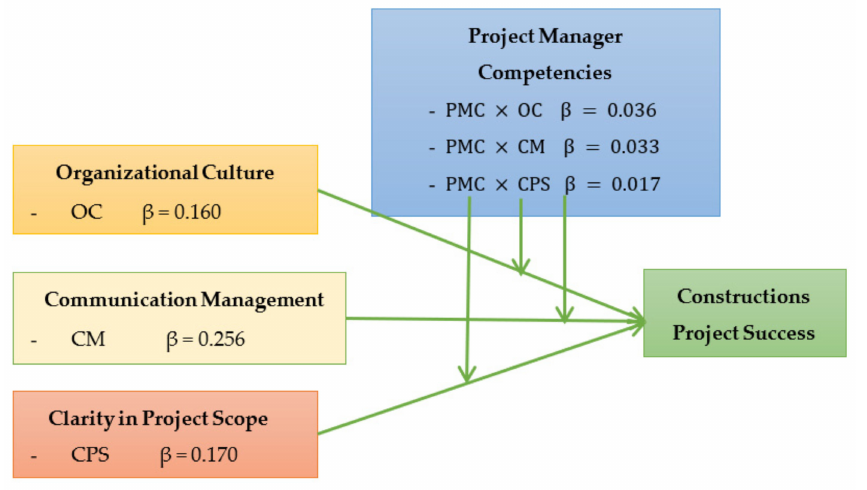
Figure 7. Operational model for Phase